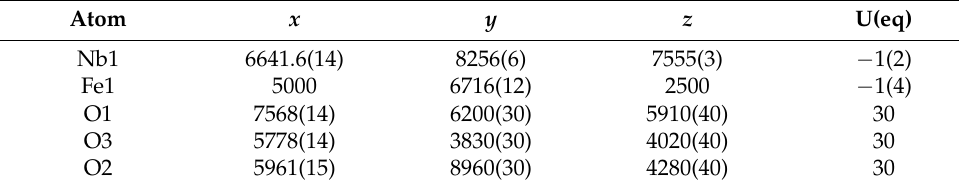
Table A3. Fractional atomic coordinates ( × 10 4 ) and equivalent isotropic displacement parameters